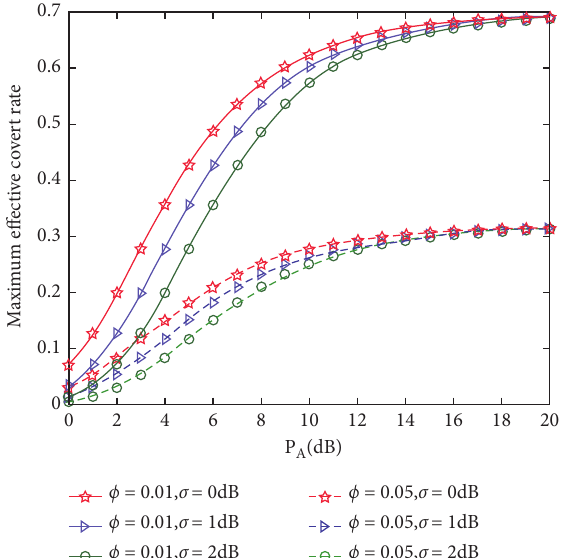
Figure 6: Maximum effective covert rate versus P value of σ 2 R and ϕ , where R � 1, | h AW | 2 � 1, | h R and N R � 3.